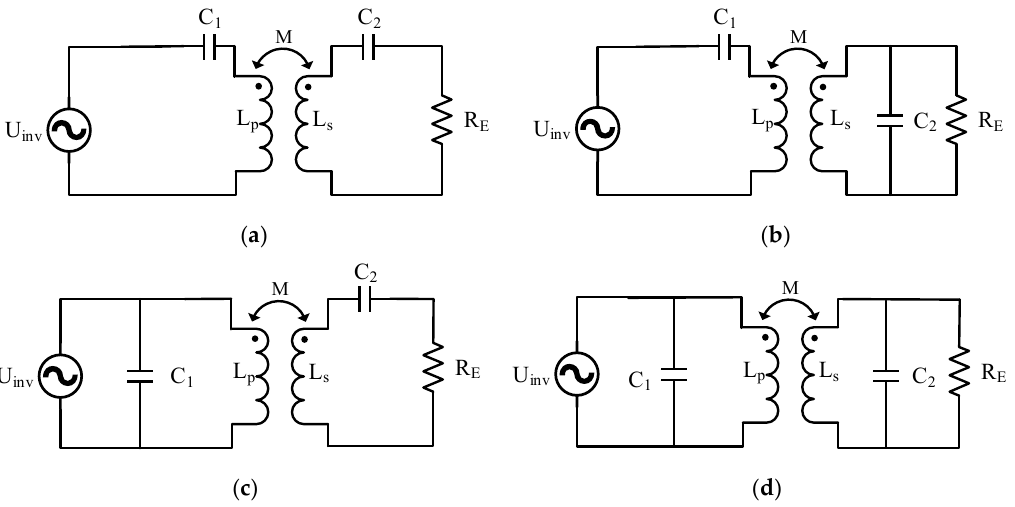
Figure 9. Block diagram of buck converter with the proposed control system.